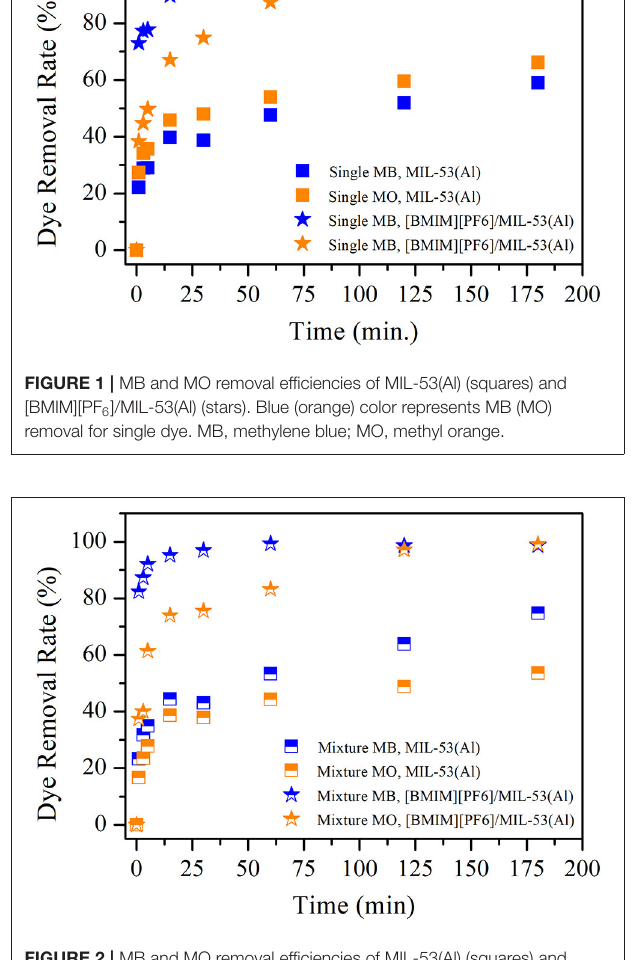
where V (L) represents the volume of the dye solution, m (mg) represents the weight of adsorbent, and C 0 (mg/L) and C e (mg/L) represent the initial and equilibrium dye concentrations, respectively. Repeated adsorption measurements indicated that the data are consistent within ±